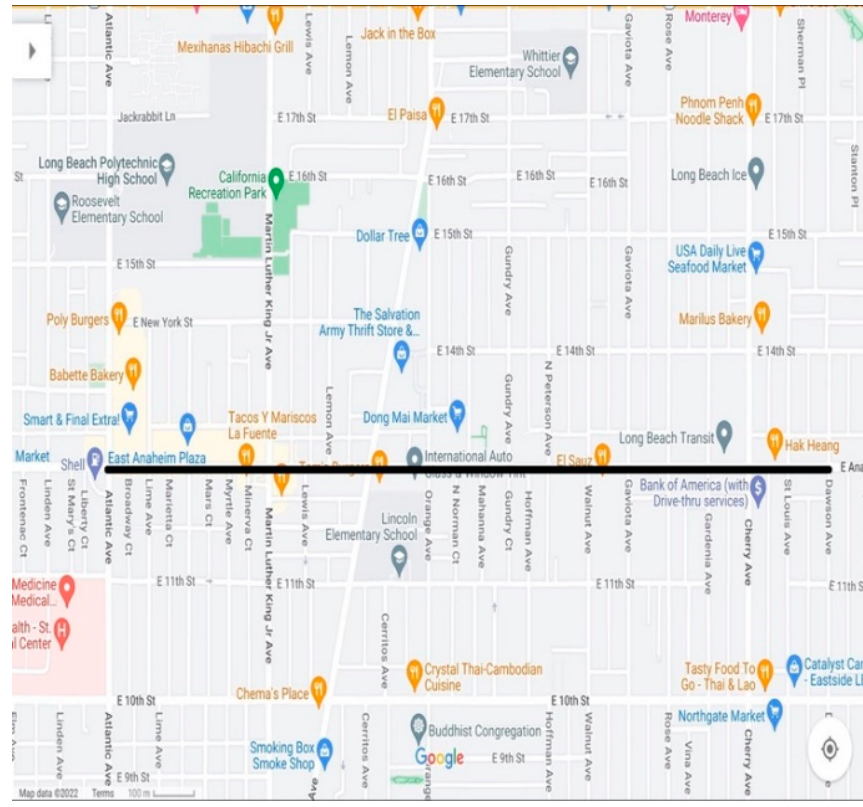
Figure 4. Path walked in Cambodia Town.